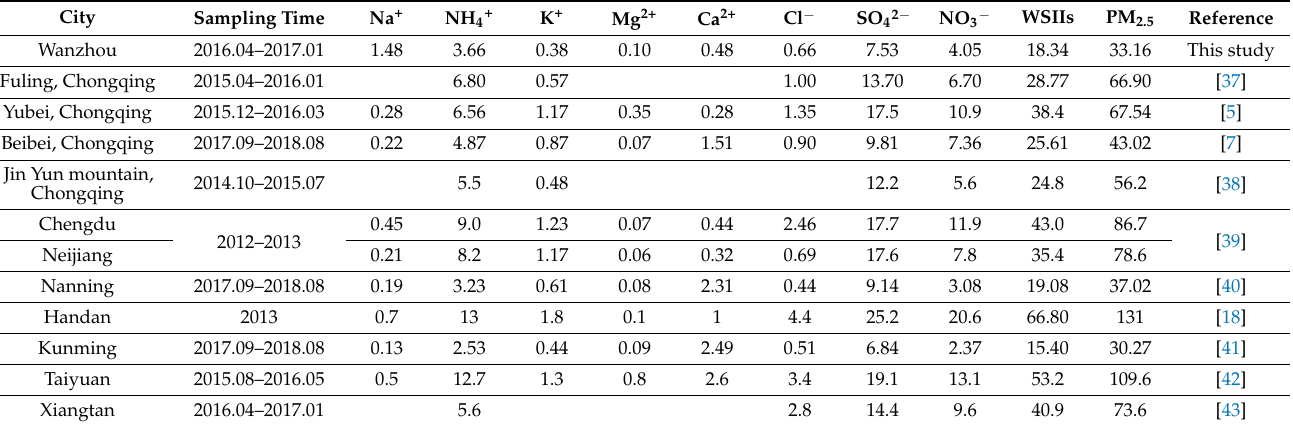
Table 2. Comparison of water-soluble inorganic ion (WSII) concentrations ( µ g · m − 3 ) in Wanzhou to other cities in China.